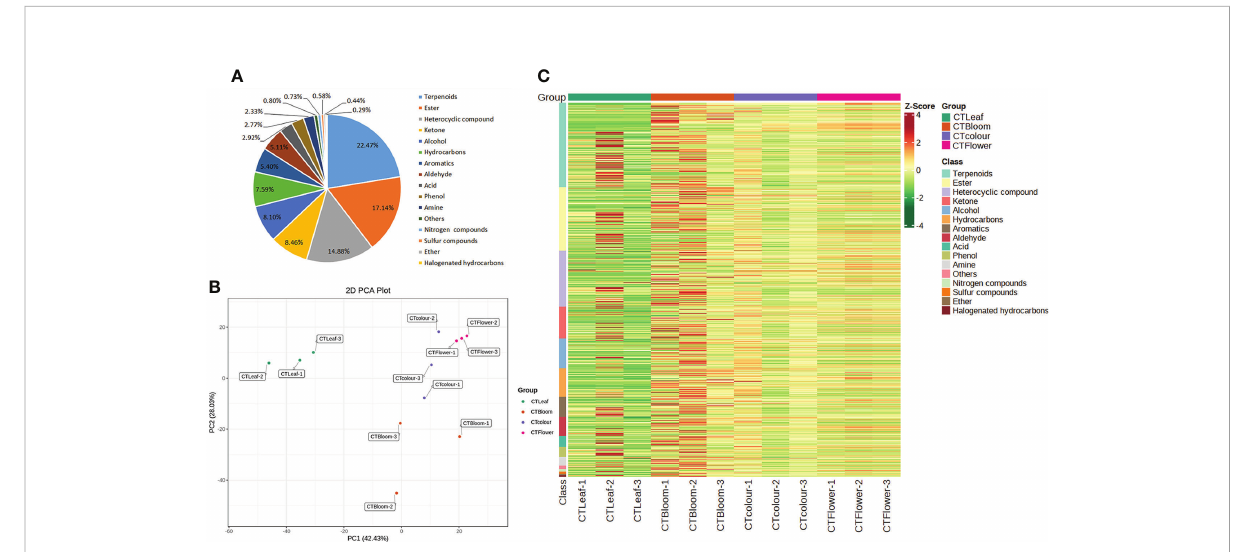
FIGURE 2 Metabolites detected in O. longilobus. (A) Classes and proportions of the metabolites detected in O. longilobus. (B) Results of the principal component analysis of the O. longilobus metabolome. (C) Heat map of the metabolites in different O. longilobus sample groups. Sample names are provided on the horizontal axis, whereas the metabolite information is provided on the vertical axis. The different colors for the Z-score represent relative contents (i.e., red and green re fl ect high and low contents,